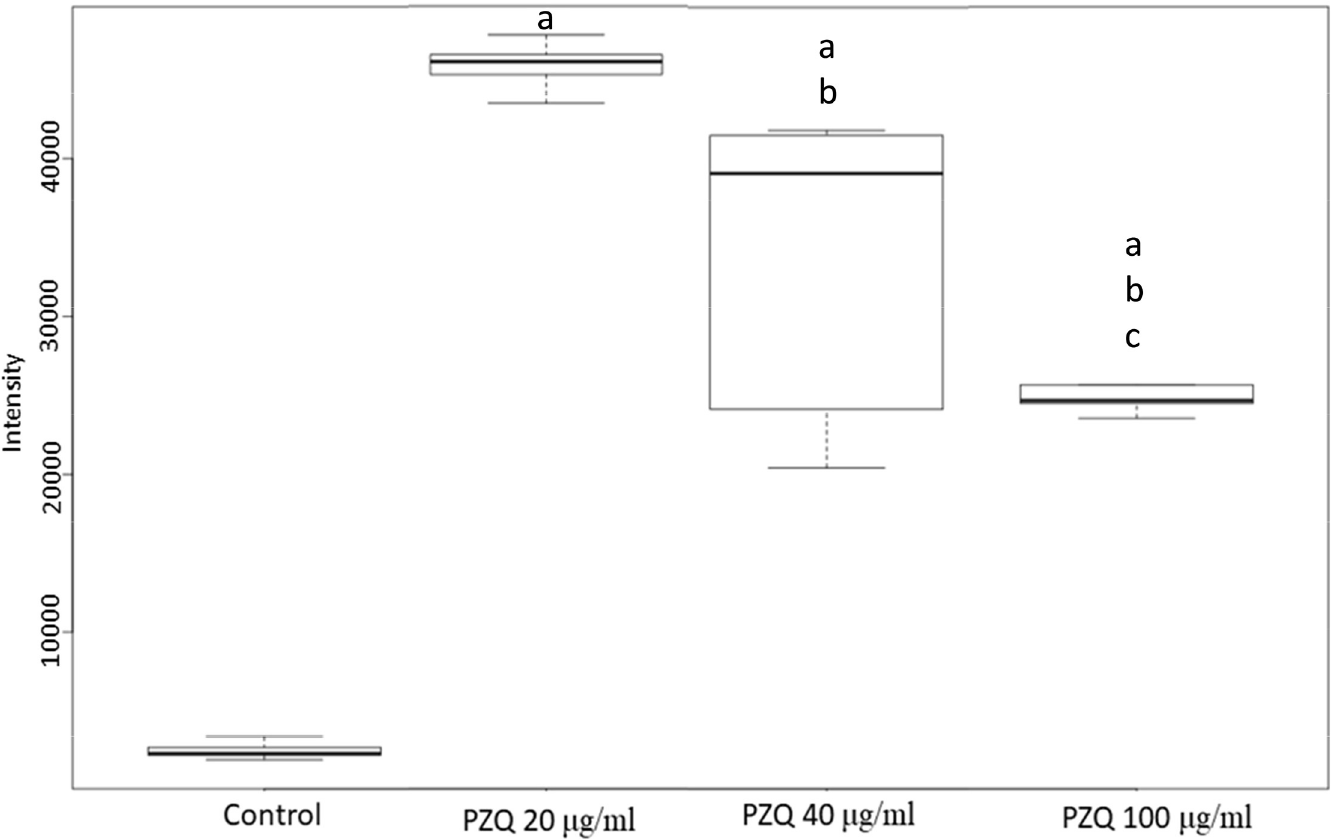
Fig 7. Decreased level of anandamide after different doses of PZQ treatment of S . mekongi . Boxplot showing levels of anandamide following different doses of PZQ. “a” indicate statistical difference at p < 0.01. “b” indicates statistical differences at p < 0.01 from low dose group. “c” indicates statistical differences at p < 0.01 from medium dose